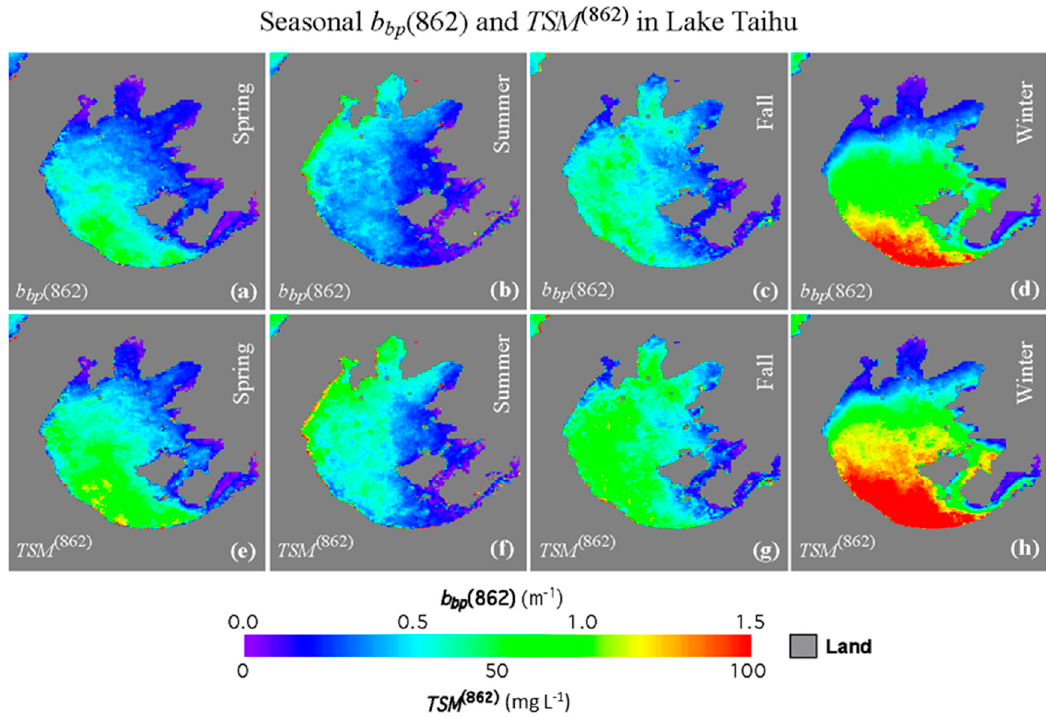
Figure 6. Seasonal climatology b bp (862) images ( a – d ) and TSM (862) images ( e – h ) for spring, summer, autumn, and winter from VIIRS 2012–2016 measurements, respectively.